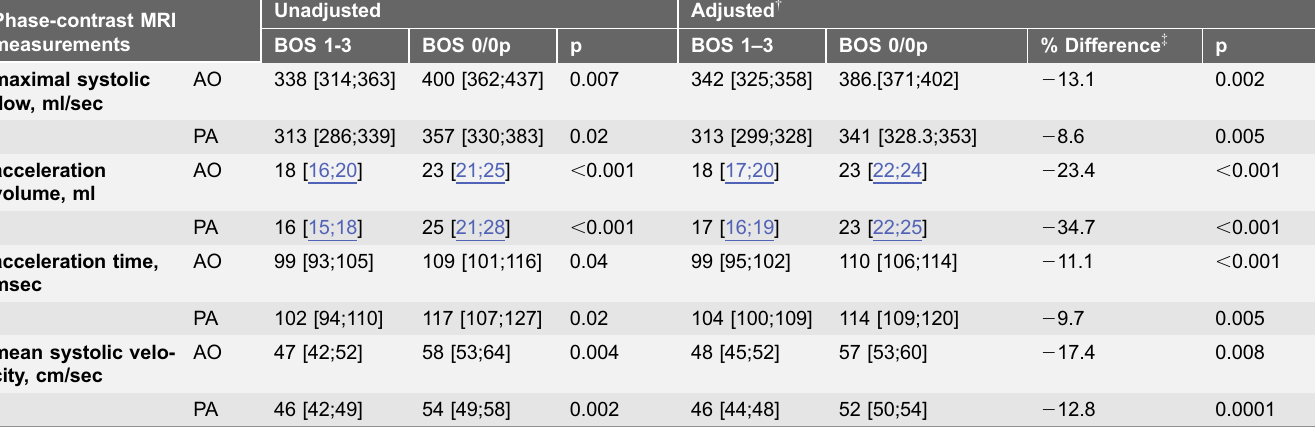
*Values are the mean ¡ standard deviation [95% confidence interval]. { adjusted for systolic and diastolic blood pressures, heart rate, exercise level, days after double lung transplantation, use of anti-hypertensive drugs, GFR, diabetes and age. { percent difference in the adjusted mean values of the indicated variable for the BOS group compared to the group without